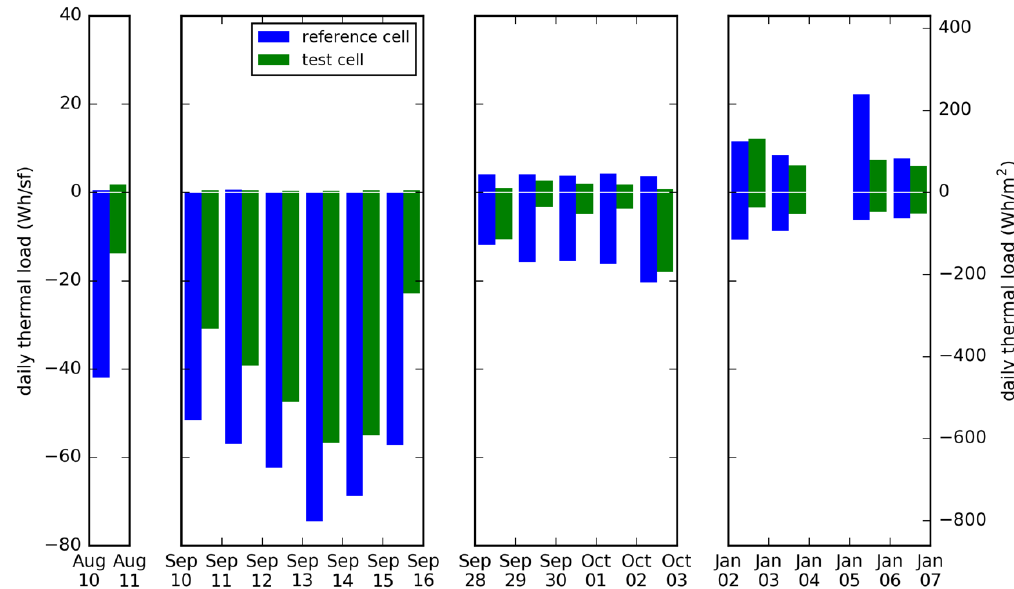
Figure 8. Daily thermal loads for test and reference cells for test days in the Core-S configuration. Values below zero are cooling loads. Values above zero are heating loads.